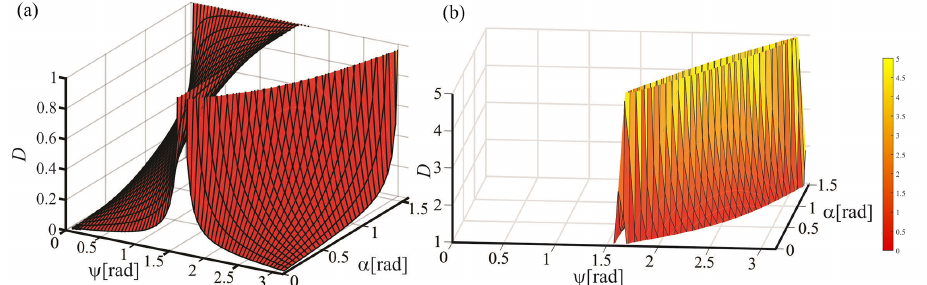
Figure 3. (a) 3-D perspective of the distortion D shown in Fig. 2, as a function of ψ and α , for underestimations of λ Z . (b) The same as in (a) , for overestimations of λ Z . Black lines in this figure are only intended to make easier a visual appreciation of the curved nature of the surfaces. The color bar illustrates D values in both plots for intervals [0,1] and [1,5] respectively.